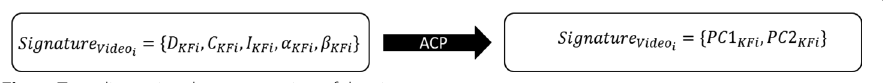
Fig. 5 Two‑dimensional representation of the